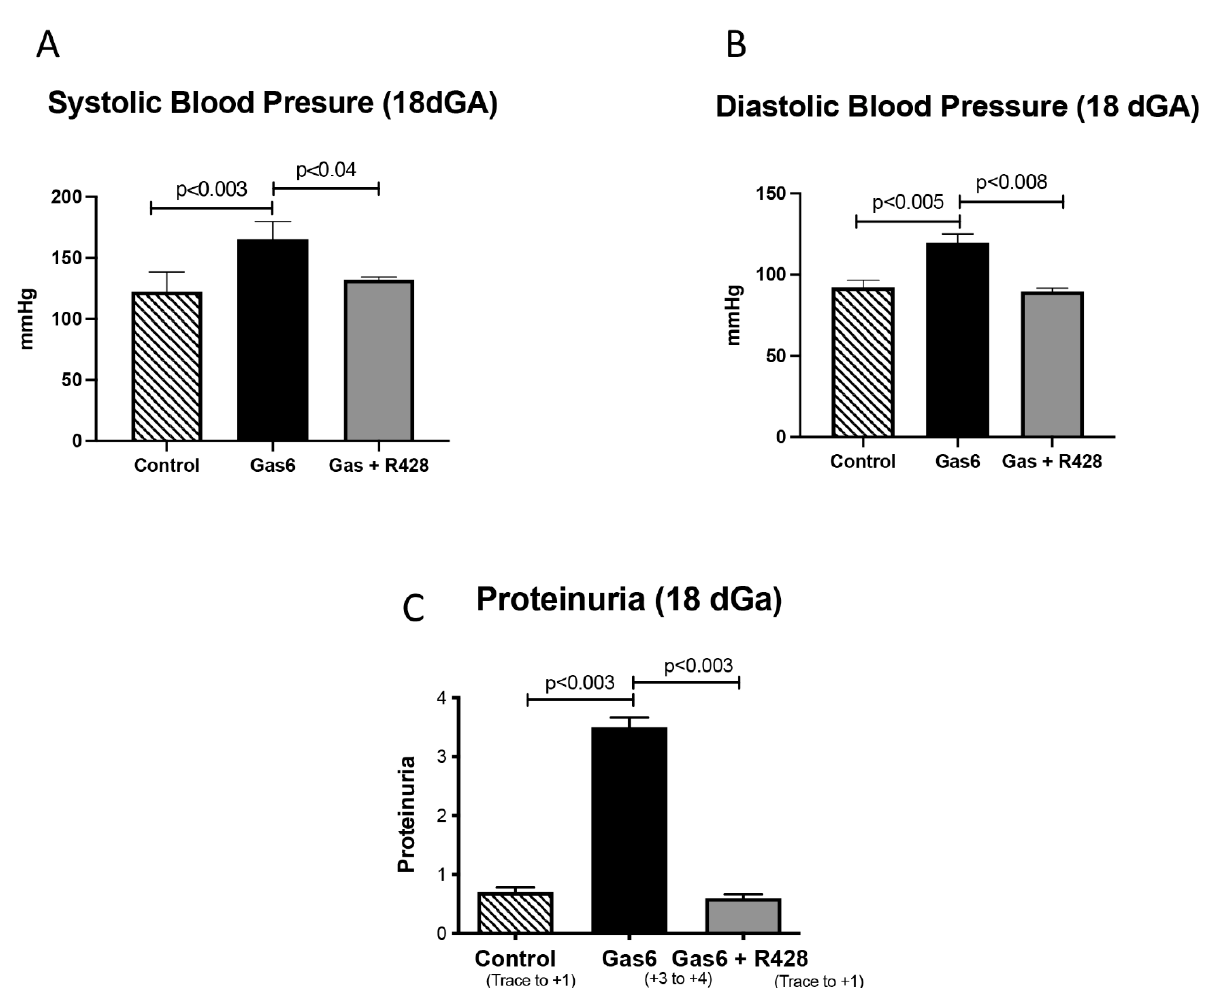
Figure 1. Blood Pressure and proteinuria during Gas6 treatment in the pregnant rat. There was an increase in blood systolic ( A ) and diastolic pressure ( B ) and urine proteinuria (+3 and +4) ( C ) in treated animals as compared to controls (n = 10). Systolic ( A ) and Diastolic ( B ) blood pressures and proteinuria ( C ) returned to basal levels in animals treated with Gas6 and the Axl inhibitor as compared to those treated with Gas6 alone. Representative data are shown with p ≤ 0.05.